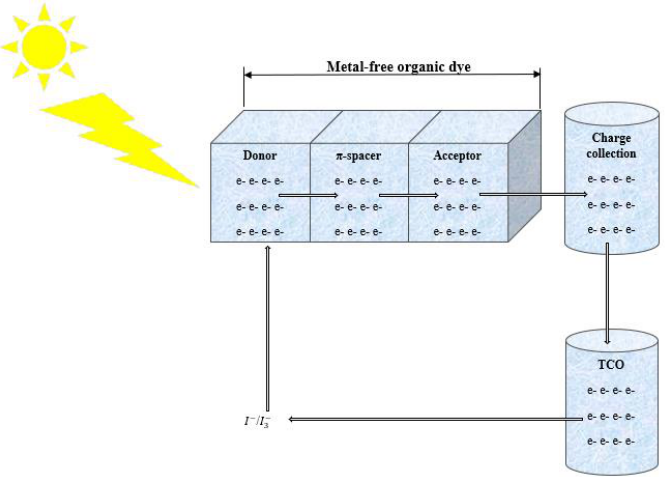
Figure 1. Mechanism for the excitation of photoelectrons within a metal-free organic dye and the regeneration of these photoelectrons back into the dye within a DSSC. Energies 2022 , 14 , x FOR PEER